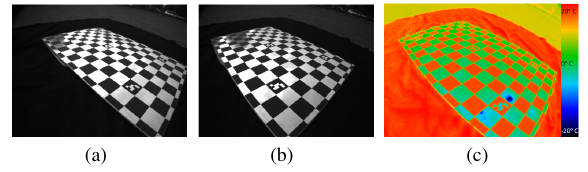
Figure 6. Synchronized calibration images of the trifocal camera system: left camera (a), right camera (b) and LWIR camera (c).